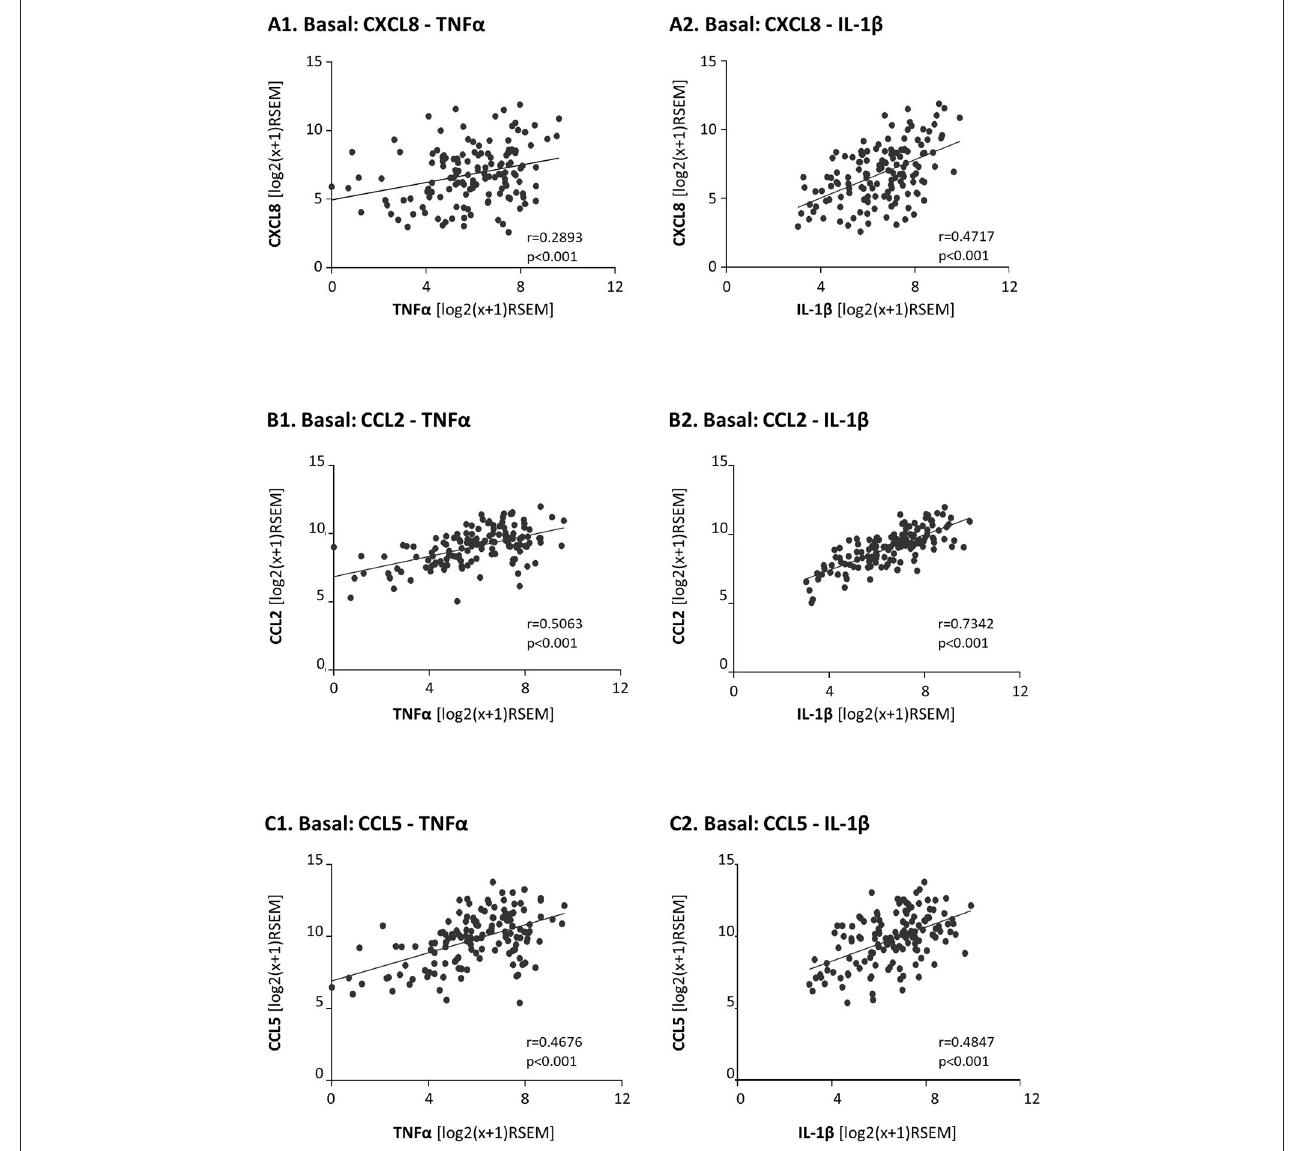
FIGURE 2 | In basal patients, the expression levels of the pro-inflammatory cytokines TNF α and IL-1 β are significantly coordinated with the expression levels of their chemokine targets. The Figure demonstrates correlation analyses of gene expression in basal patients, performed with the TCGA breast cancer dataset. (A) CXCL8 correlations with TNF α (A1) and IL-1 β (A2) . (B) CCL2 correlations with TNF α (B1) and IL-1 β (B2) . (C) CCL5 correlations with TNF α (C1) and IL-1 β (C2) . RSEM, RNAseq by expectation-maximization.